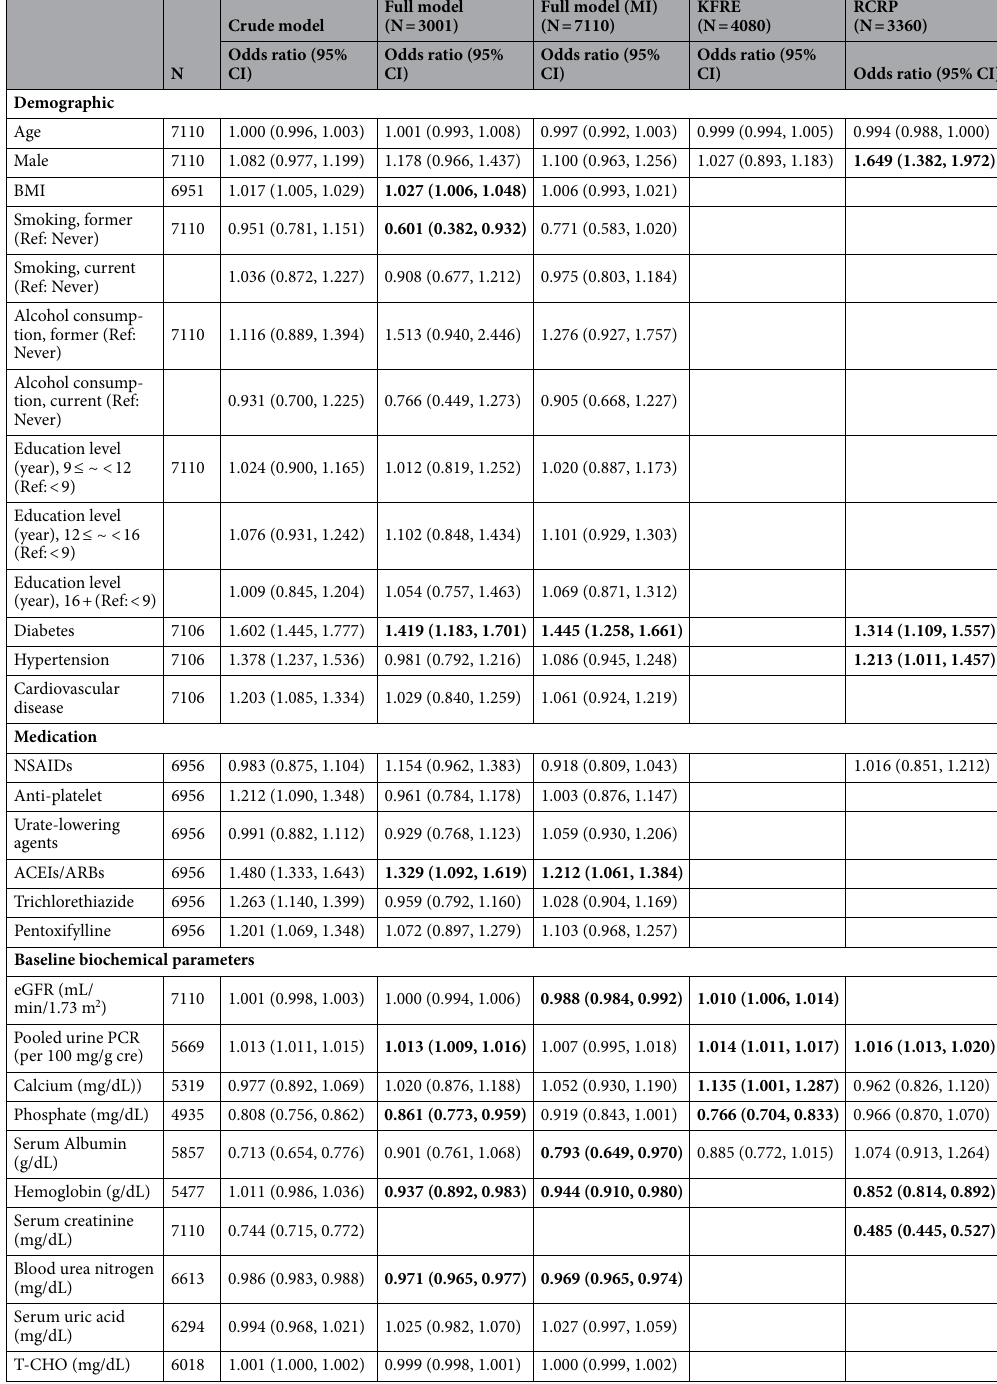
Table 4. Factors associated with nonresponsiveness to pre-ESRD care based on multiple logistic regression in the crude model, full model (with and without imputation), KFRE (Kidney Failure Risk Estimation), and RCRP (Renal Care Responsiveness Prediction). ACEIs Angiotensin-converting-enzyme inhibitors, ARBs Angiotensin II receptor blockers, BMI body mass index, CI confidence interval, CKD chronic kidney disease, eGFR estimated glomerular filtration rate, ETR event time ratio, ESRD end stage renal disease, NSAID nonsteroidal anti-inflammatory drugs, PCR protein/creatinine ratio, RCRP renal care responsiveness prediction. Odds ratios labeled in bold are statistically significant at the level of alpha =